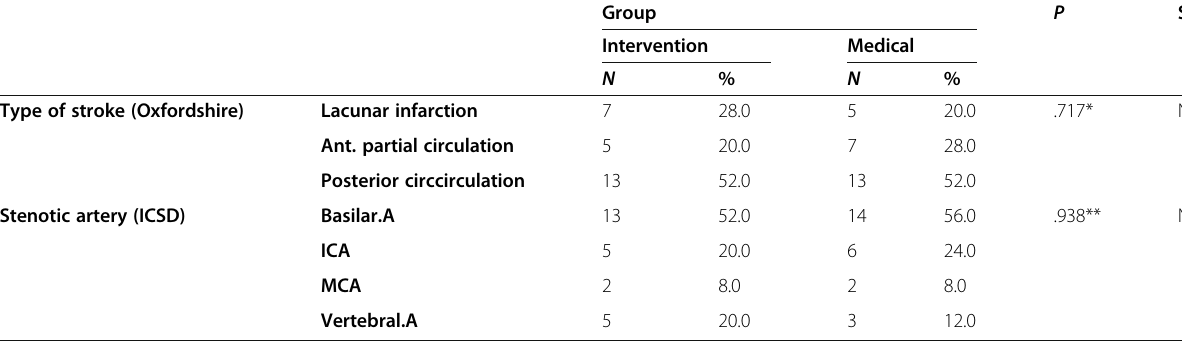
Table 2 Type of stroke and site of ICSD among both groups